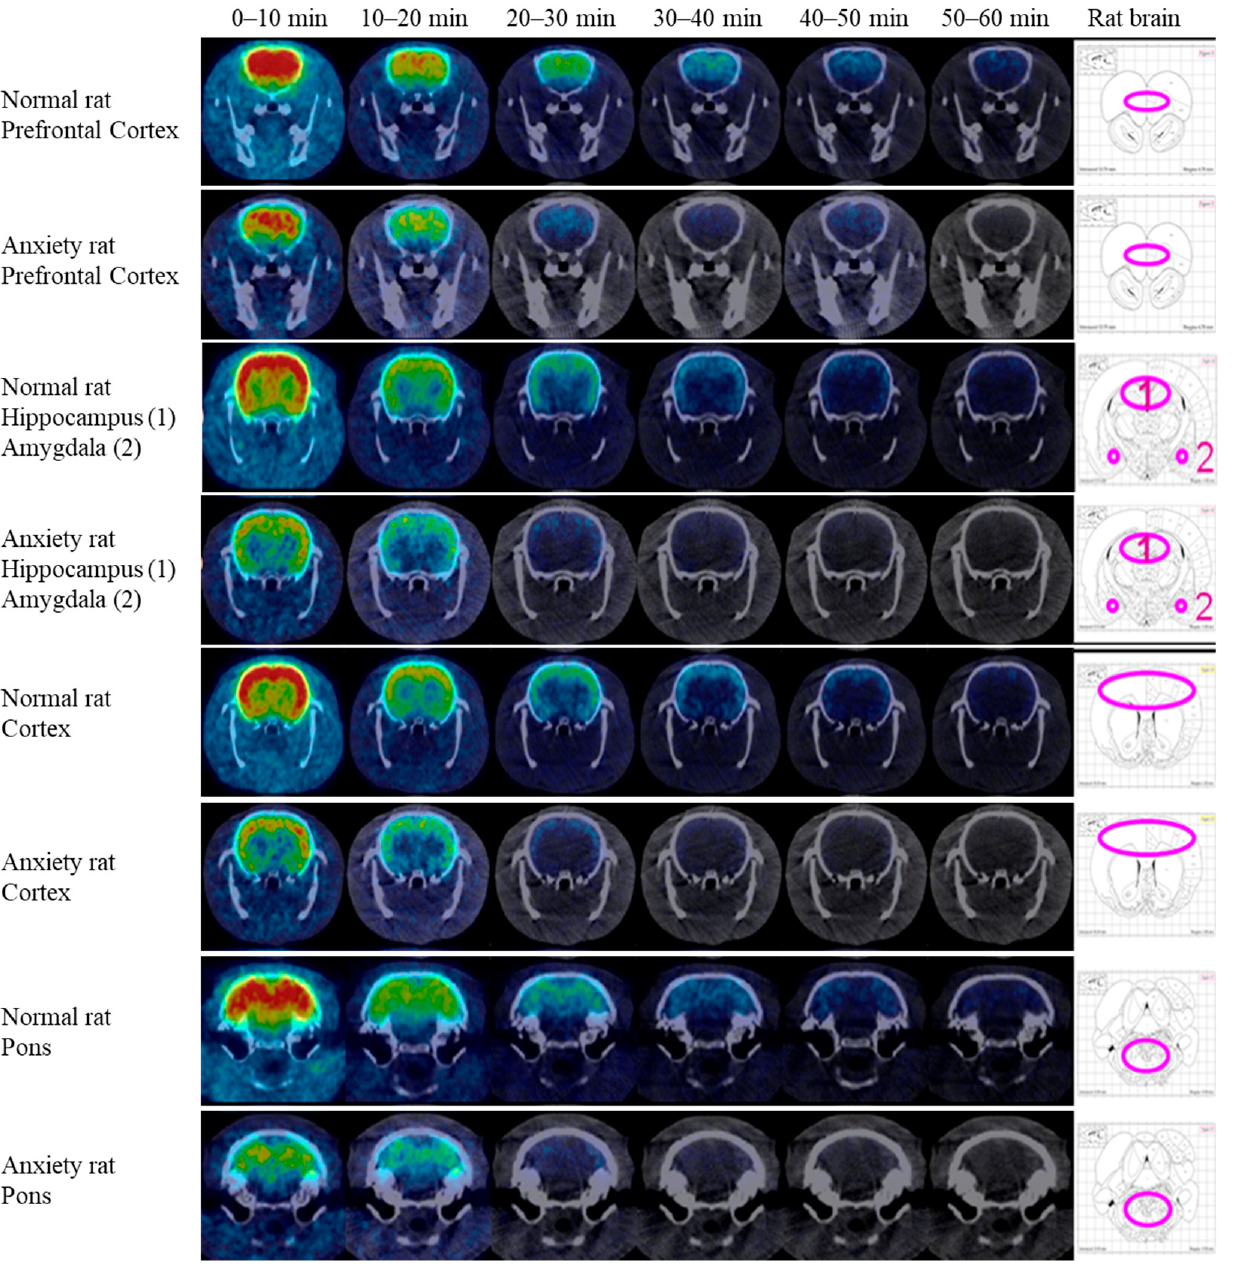
Figure 4. The brain regional distribution of GABA A receptors as imaged by [ 18 F]flumazenil NanoPET/CT in fear-conditioned (anxiety) and normal rats. The acquired NanoPET/CT dynamic series were reconstructed with NanoPET/CT images, consisting of six time frames (0–10, 10–20, 20–30, 30–40, 40–50, 50–60 min). After injection of [ 18 F]flumazenil, peak uptake was observed at the first time frame (0–10 min post-injection) in both fear-conditioned rats and normal rats. In all time frames, the normal rats displayed markedly higher uptake of [ 18 F]flumazenil than the fear-conditioned rats in the prefrontal cortex, cortex, amygdala, and hippocampus. The pons was delineated as ROIs and used as a reference region.